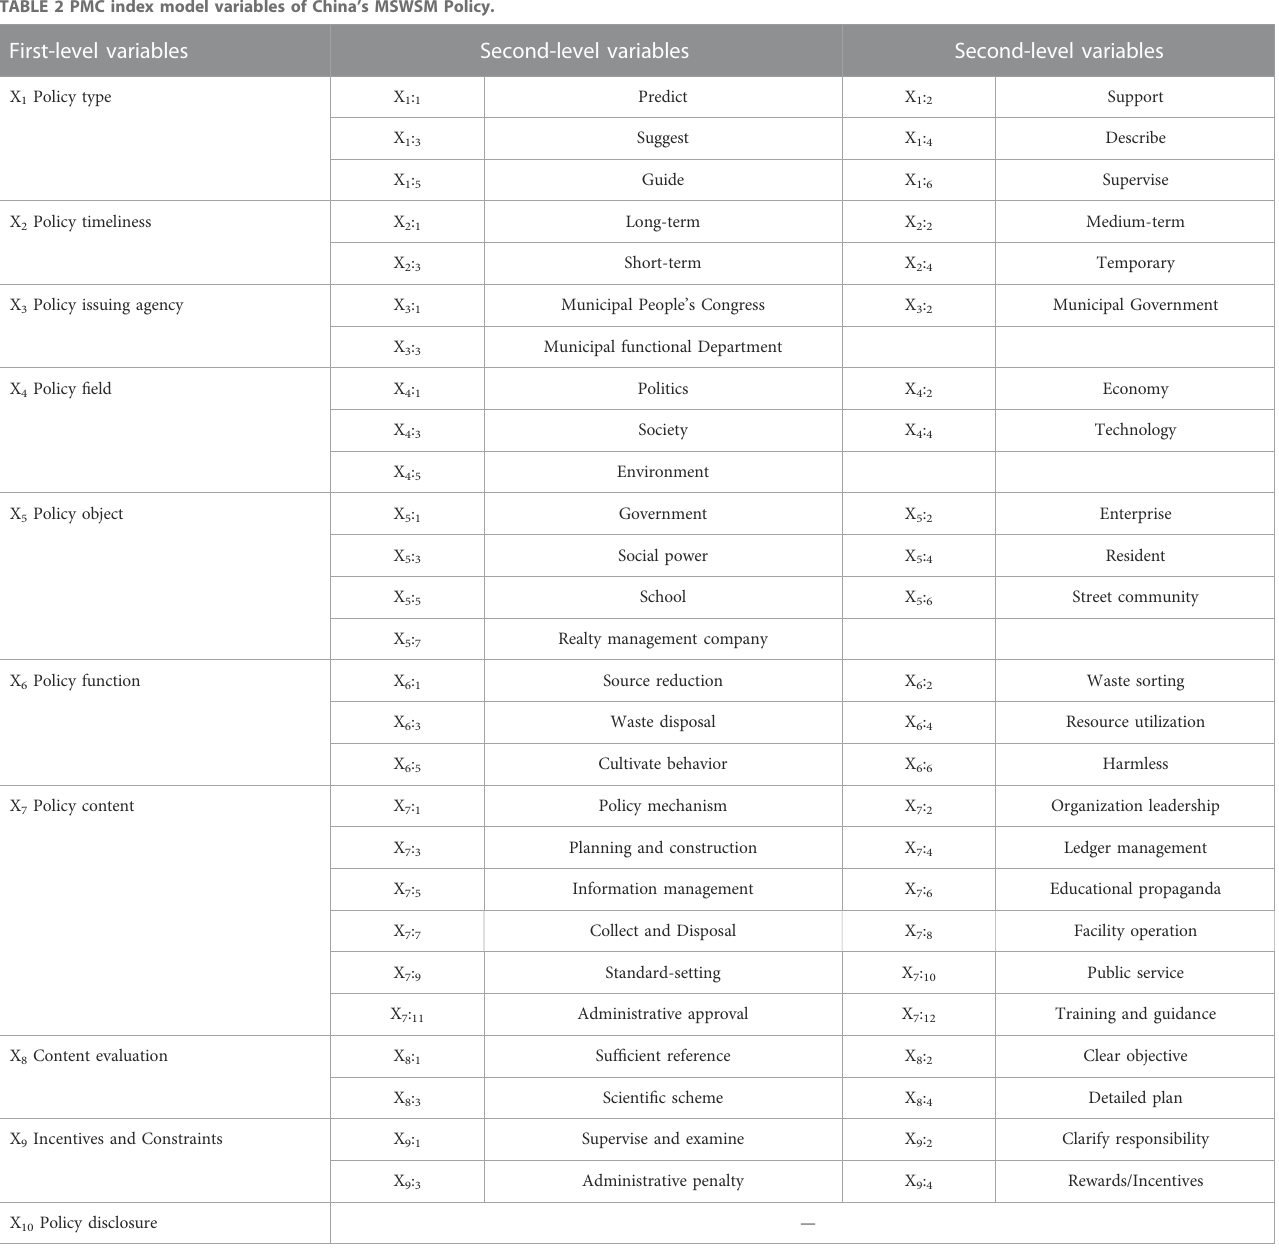
TABLE 2 PMC index model variables of China ’ s MSWSM Policy. First-level